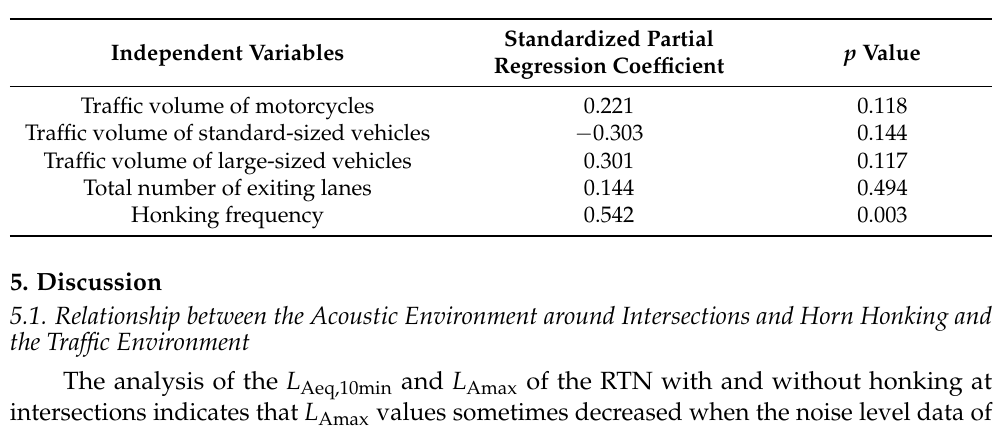
Table 11. Result of multiple regression analysis for L Amax